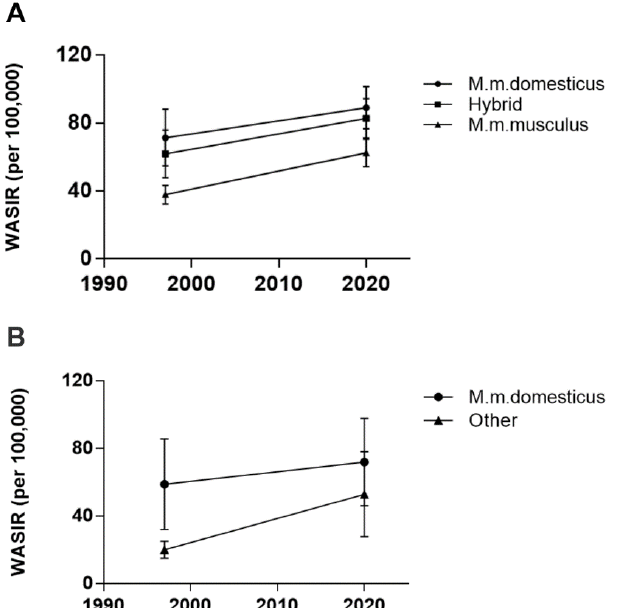
Figure 1. Mean world age-standardized incidence rates of breast cancer in 1997 versus 2020 according to the range of M. m. domesticus in Europe ( A ) and non-European lands ( B ), excluding sub-Saharan Africa. Data are presented as mean ± standard deviation. Table 1. Change in breast cancer incidence rate from 1997 to 2020 in Europe sorted by mouse range.